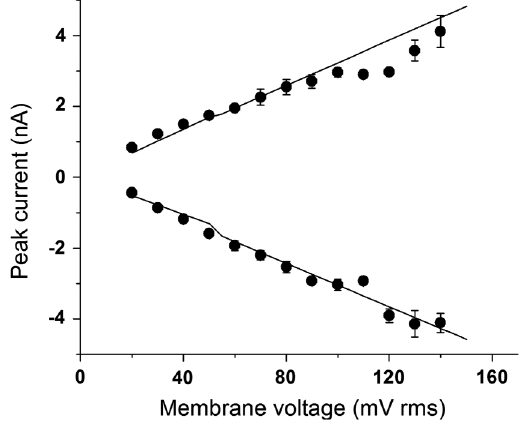
. The peak 0 is increased. The solid 0